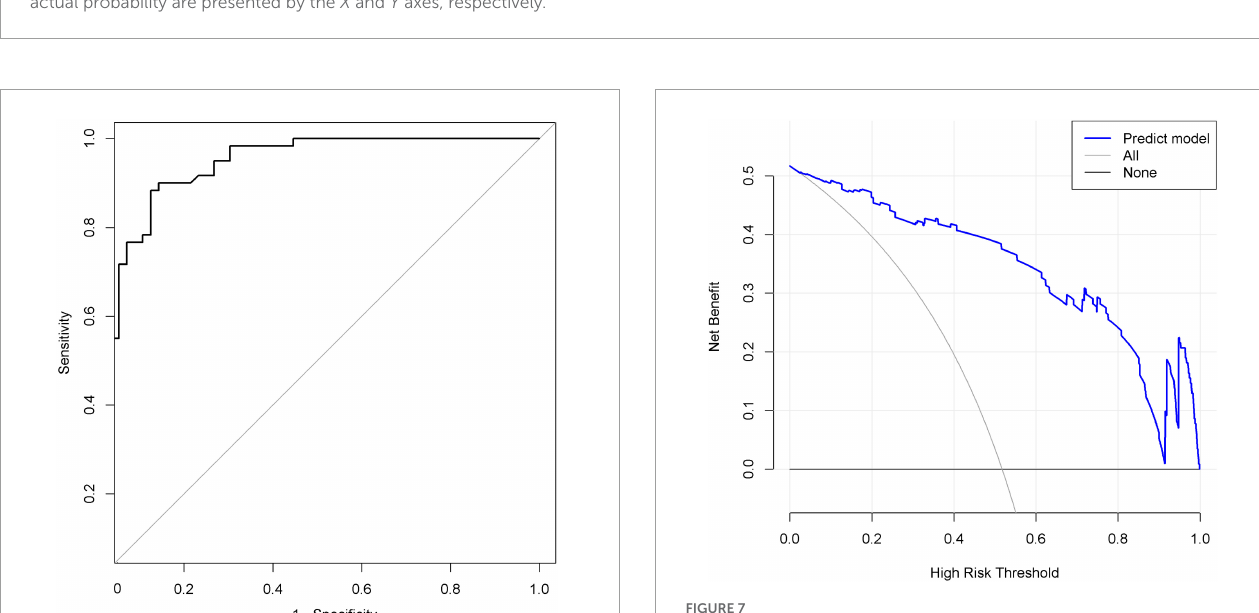
FIGURE7 Decision curve analysis (DCA) of the nomogram. X -axis and y -axis represent threshold probability and net benefit, respectively. When the threshold probability value of the predictive model is between 0.05 and 0.92, the patients will obtain the corresponding net